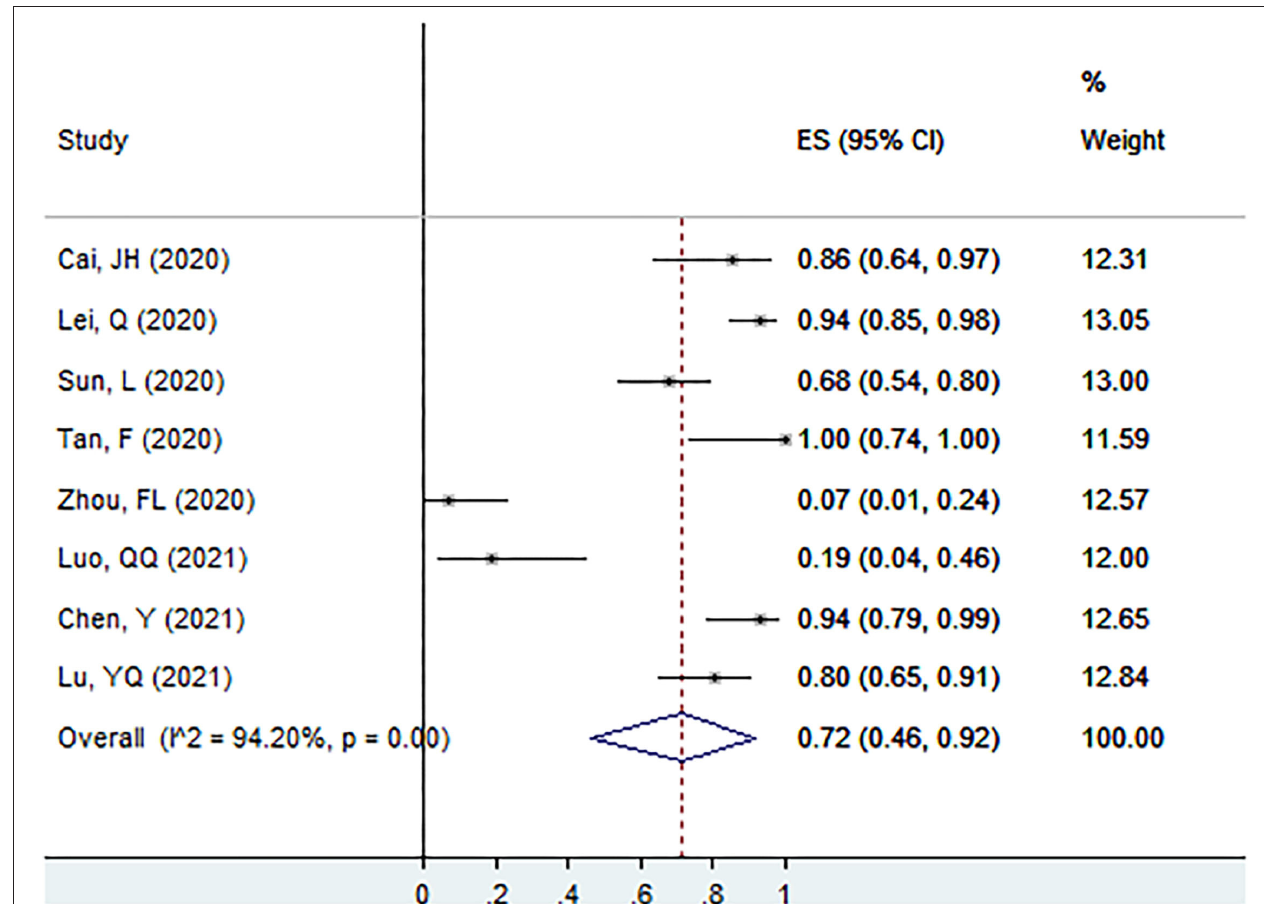
FIGURE 4 | The proportion of Ig G + in patients with asymptomatic infection at the screening